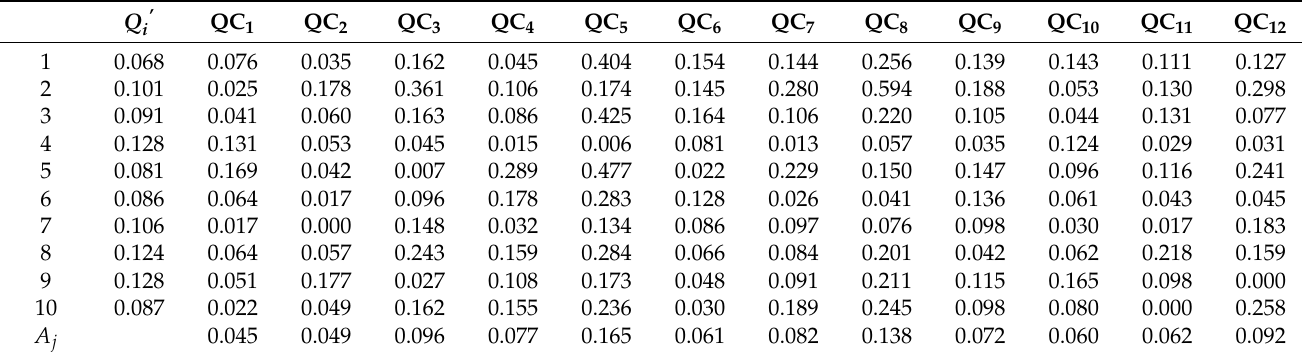
Table 2. Table of mapping between VOC and QCs.